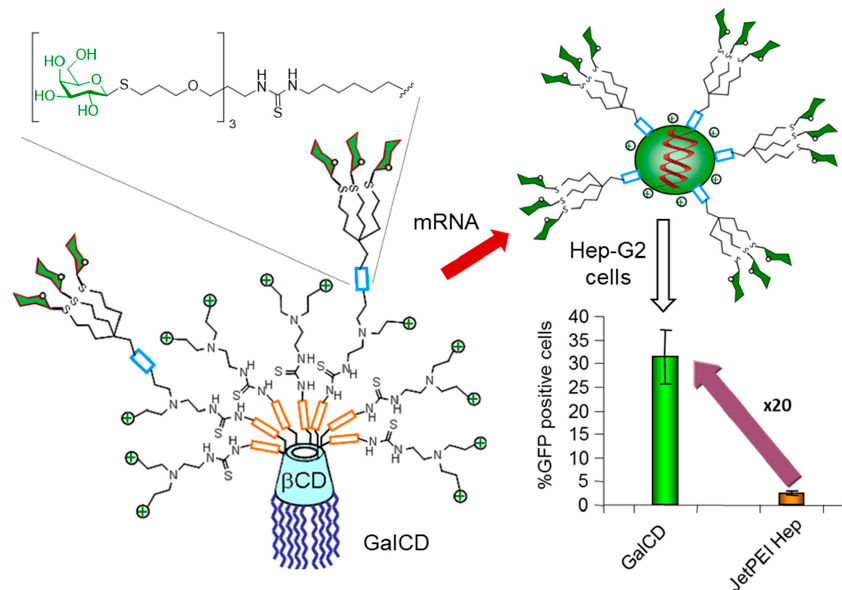
Figure 16. Schematic representation of the statistically galactosylated paCD (GalCD) vectors used by Rejman and coworkers to formulate glycoCDplexes with mRNA for the ASGPR-mediated transfection of hepatocytes [167].